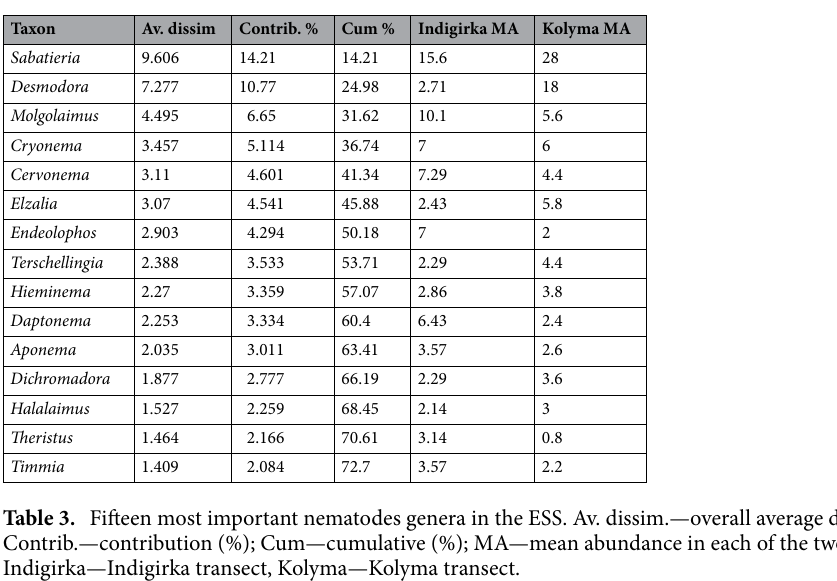
genus diversity (15 genera) and strong dominance by two genera, Sabatieria and Desmodora (Table 2). SIMPER analysis showed that the broadly distributed abundant nematode genera as Sabatieria, Desmodora, Molgolaimus, Cervonema, Elzalia and Daptonema were primarily responsible for the dissimilarity observed among two tran- sects (Table 3). The multivariate analysis revealed the combined effect of depth and organic content in sediment on nematode community structure at the level of the genera (Fig. 6). The PCA showed that the first compo- nent accounted for 26.7% of the total variability and reflected the general along transect trend from shallower warm brackish water (station 5598, 5600, 5617, 5619) to deeper cold salt waters (Fig. 6). The second compo- nent accounted for 14.7% of the total variance and correlated with total organic carbon in sediment. The most